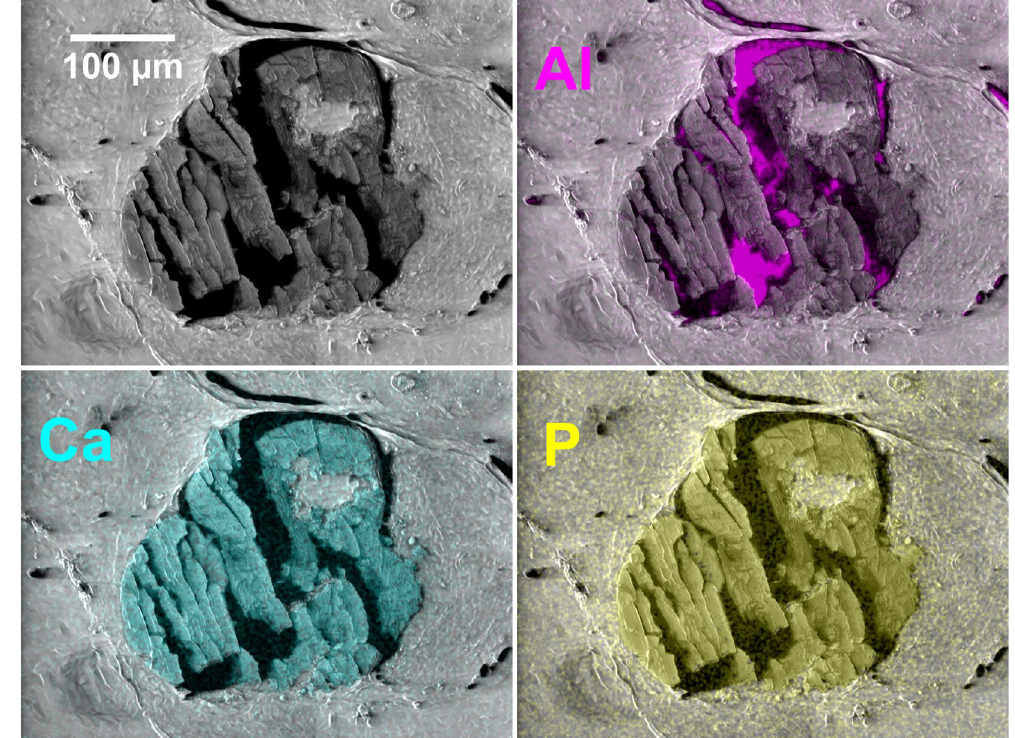
Figure 1. SEM image of a typical calcification overlaid with EDS elemental maps. The aluminium substrate can be seen through the cracks in the calcification resulting from sectioning. (Specimen S44 – pathology details in Supplementary Table